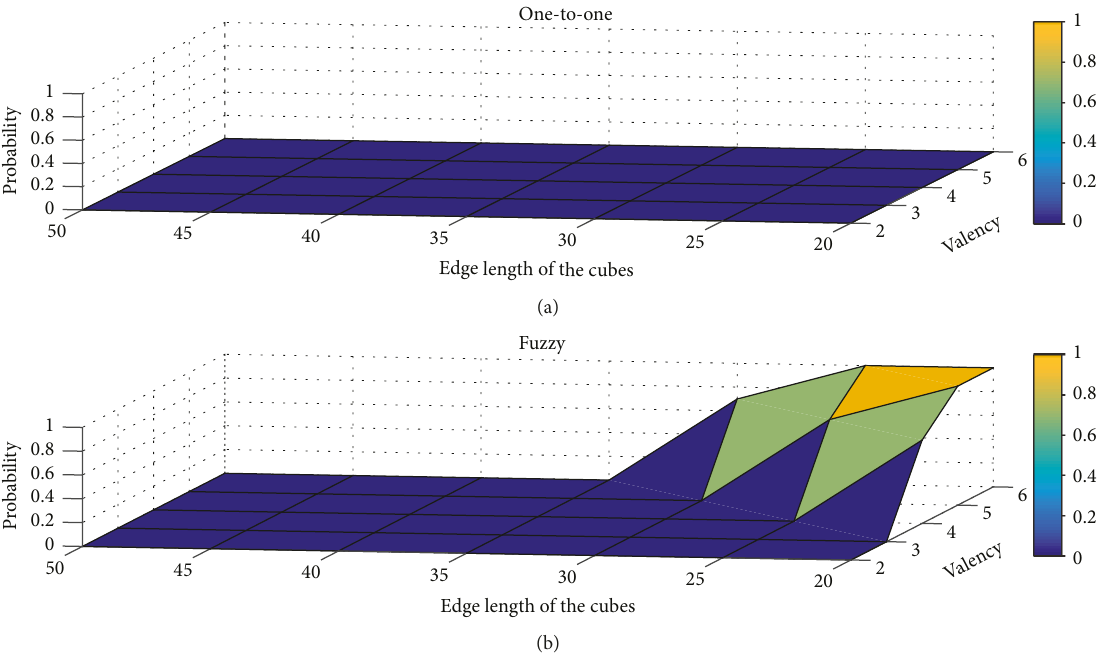
Figure 3: Probability of large polymers as a function of valency and length of the simulation box (in residue units) in one-to-one (a) and fuzzy (b) binding models. Valency is de fi ned as the number of binding elements. Concentration is the number of molecules/volume (L 3 ). Binding element a ffi nity =0.35; linker dynamics =0.35.